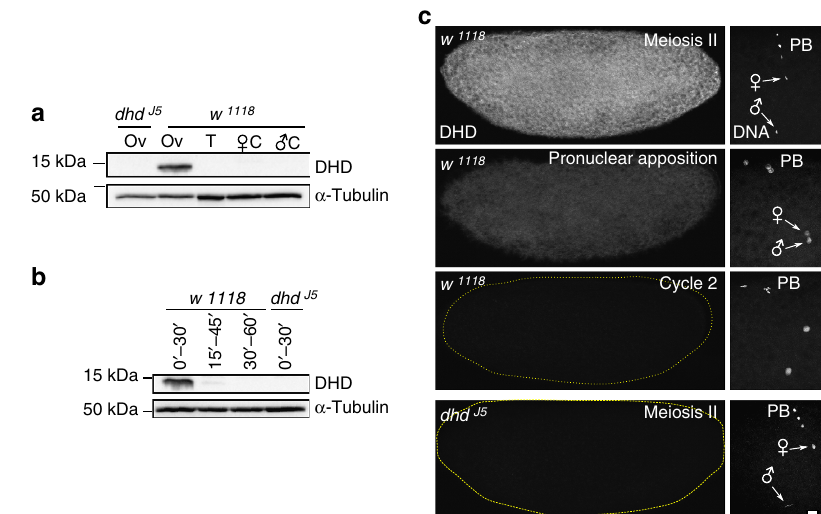
Figure 5 | Expression and distribution of maternally-expressed DHD protein. ( a – b ) Western blot analyses of DHD expression in adult tissues (a) or embryos collected during the indicated time windows after egg laying ( b ). a -tubulin was used as loading control. Ov: ovaries, T: testis, C: carcasses. See also Supplementary Fig. 6. ( c ) Confocal images of eggs or embryos laid by w 1118 or dhd J5 females and stained for DHD (left) and DNA (right). A close-up of the region containing the nuclei is shown on the right (arrows: male and female nuclei; PB: polar bodies). Scale bar, 10 m m